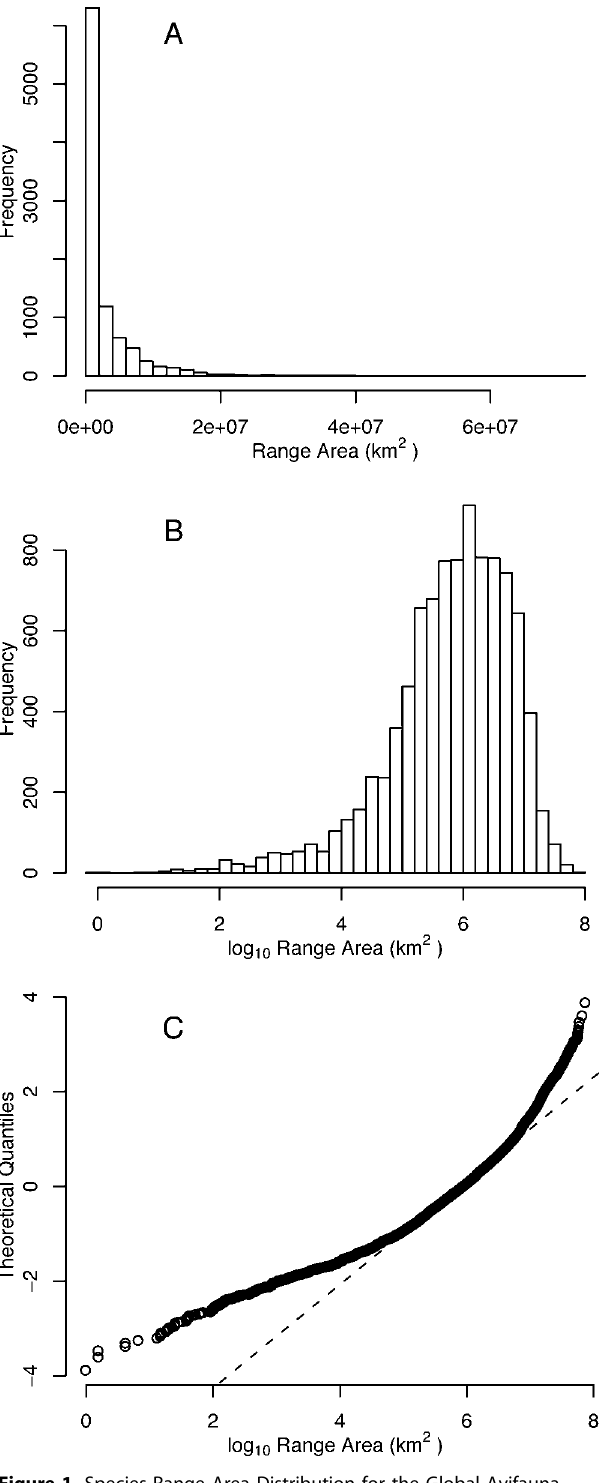
Figure 1. Species-Range Area Distribution for the Global Avifauna (A) Untransformed range areas. (B) Log 10 -transformed range areas. (C) Normal probability plot for log 10 -transformed range areas, showing the expectation under a normal distribution (dashed line) and the observed distribution (open